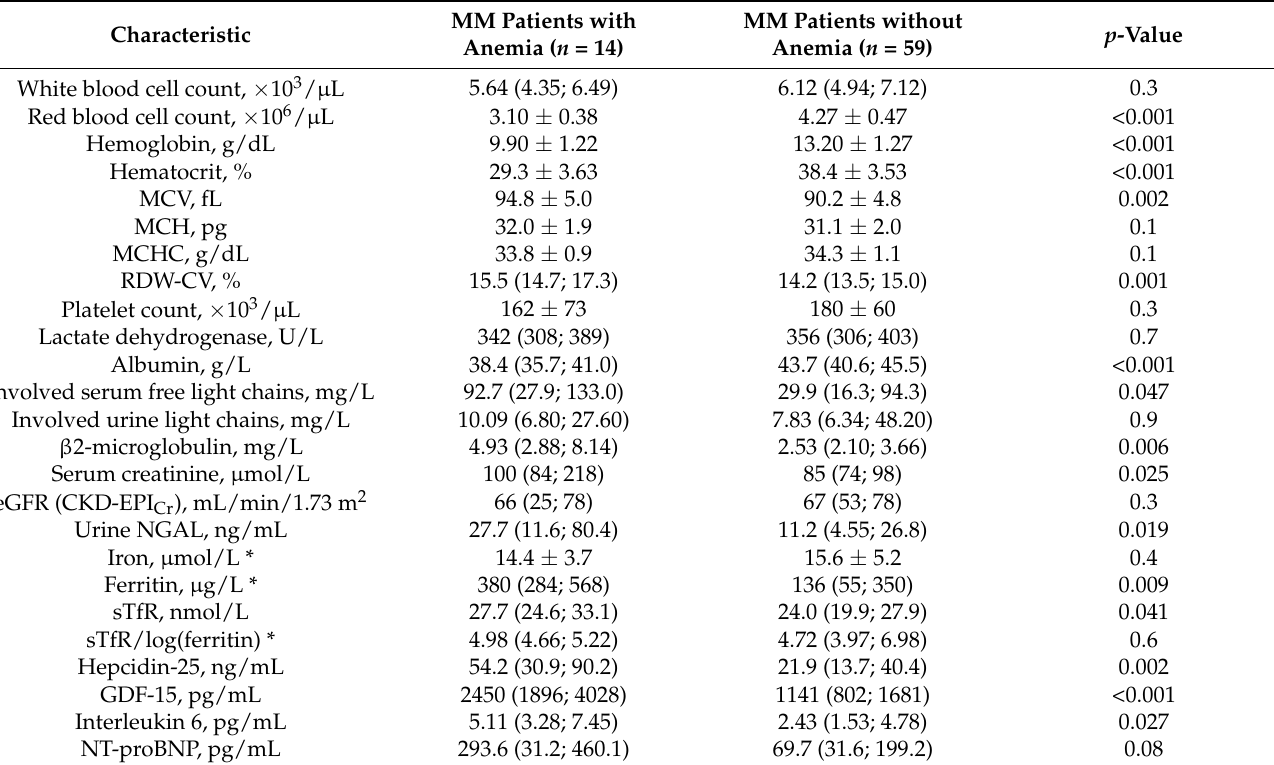
Table 2. Baseline results of laboratory tests among studied MM patients with and without anemia. Data are shown as median (lower; upper quartile) or mean ± standard